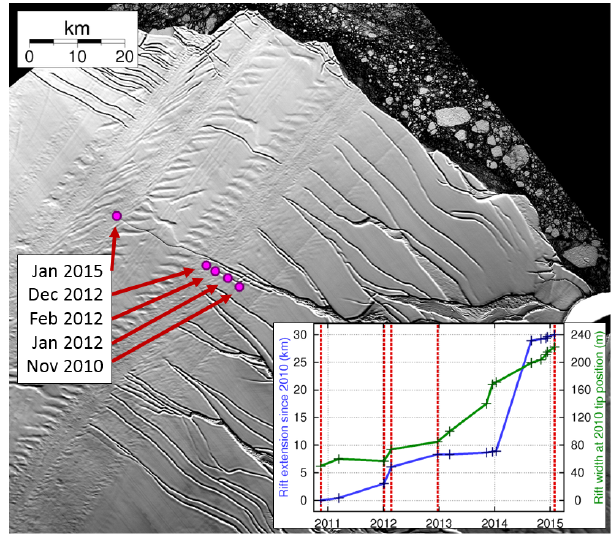
Figure 2. Analysis of rift propagation using Landsat data. Back- ground image, in which the rift is visible, is from 4 December 2014. Inset graph shows the development of rift length with respect to the 2010 tip position, and rift width at the 2010 tip position, measured from all available Landsat images (crosses; 15 in total). The line joining data points illustrates only the mean propagation rate be- tween observations. Actual propagation of the rift may be sporadic and true propagation rates cannot be known without regular fre- quent observations, which are not available. Circles and labels on the map, and dotted red lines on the graph, show the positions of notable stages of rift